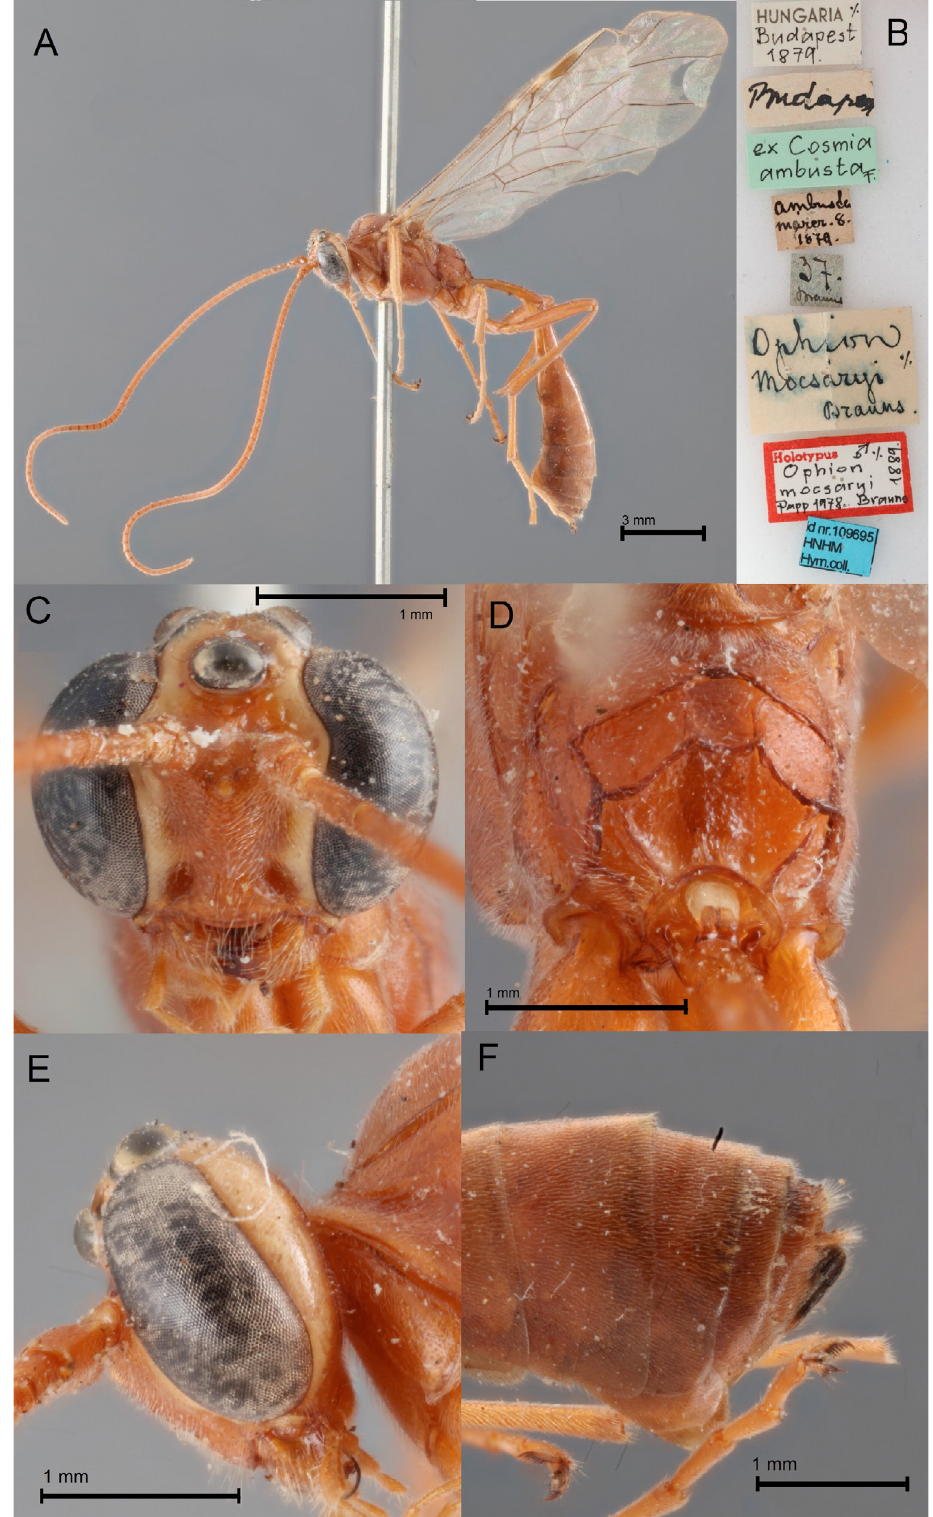
Fig. 48. Ophion mocsaryi Brauns, 1889, holotype, ♀ (HNHM). A . habitus, lateral view. B . Labels. C . head, anterior view. D . Propodeum, posterodorsal view. E . head, lateral view. F . Posterior segments of metasoma, lateral